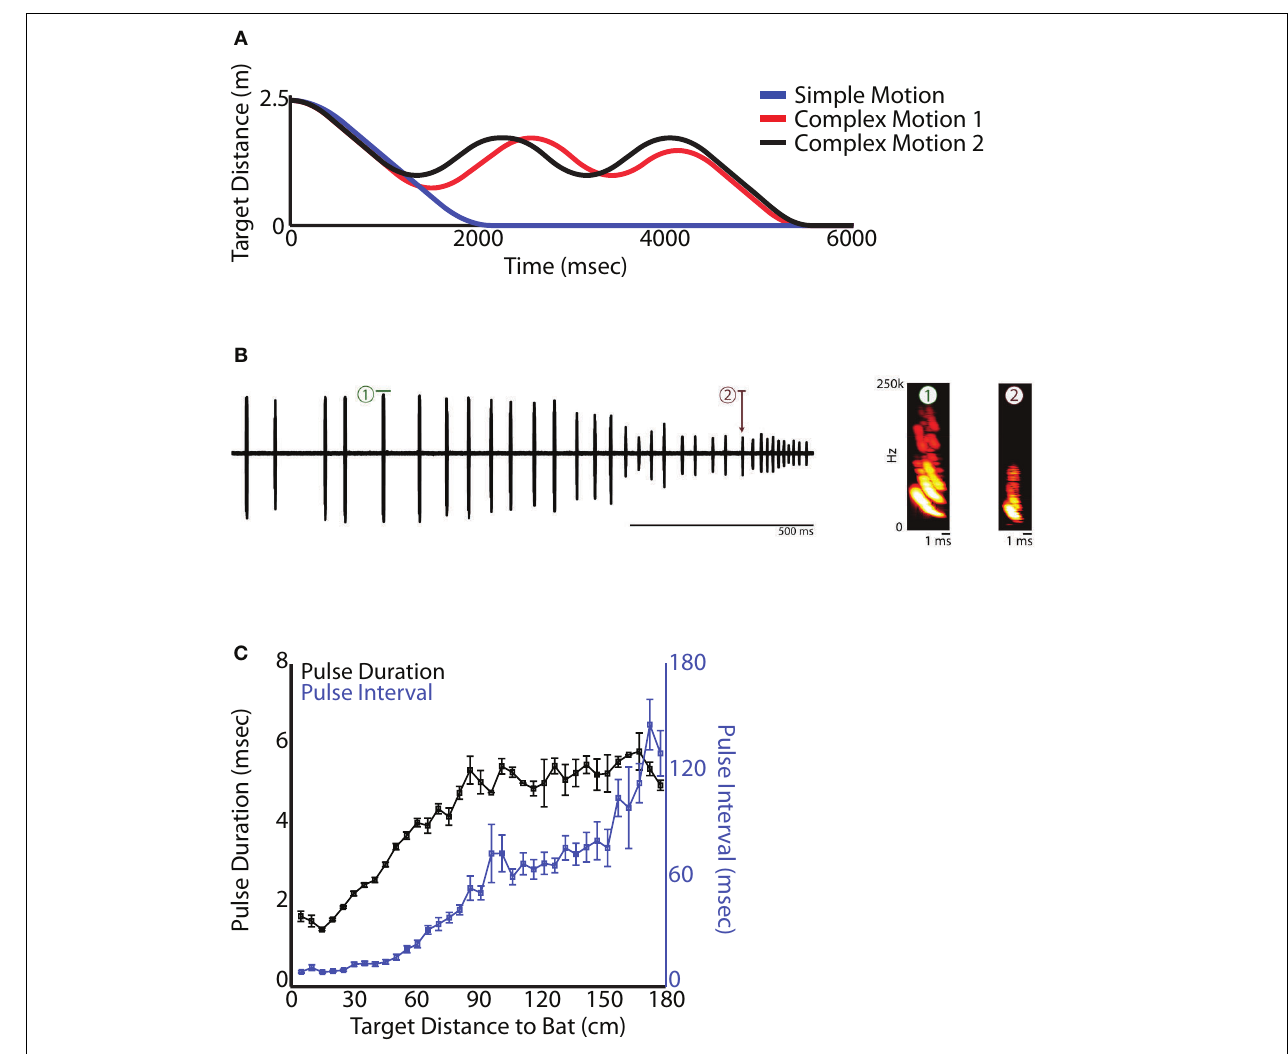
FIGURE 3 | Platformexperiment.(A) Distancevs.timeforeachtypeoftarget motion of the tethered mealworm. The blue line represents simple motion in only one direction, while the red and black lines are the more complicated, back-and-forth motions. (B) Left, example oscillogram of a sequence of vocalizations produced by a bat tracking a tethered mealworm in the setup